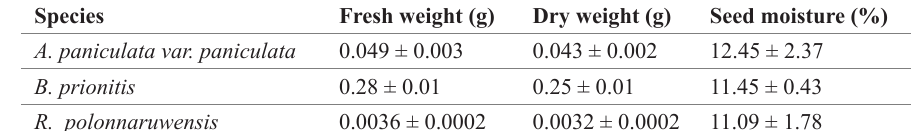
Table 1: Fresh and dry mass (g) and moisture content (%) of the mature seeds (mean ± SD, n = 10) of the three tested species Species